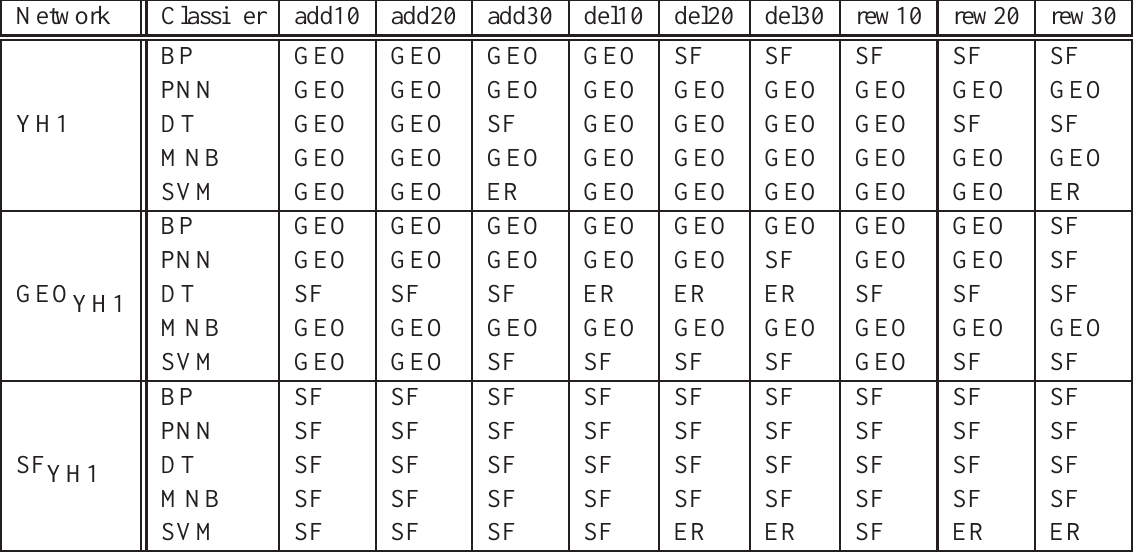
Table 2: The best-fitting network models (ER, GEO, SF) predicted by the five classifiers (BP, PNN, DT, NBM, and SVM) for noisy networks. The networks to which the noise is added are: YH1 network, as well as a GEO and an SF network of the same size as YH1, denoted by “GEO YH1 ” and “SF YH1 ”, respectively (listed in column 1). We obtained noisy networks by randomly adding, deleting, and rewiring 10%, 20%, and 30% of edges (columns 3-11, respectively). For each of YH1, GEO YH1 and SF YH1 and for each of the randomization schemes, we constructed 10 instances of noisy (randomized) networks, resulting in the total of 3 × 9 × 10 = 270 noisy networks. For each of YH1, GEO YH1 and SF YH1 , the classifiers predicted the same model for all instances of noisy networks in the same randomization scheme; predicted models are reported in columns